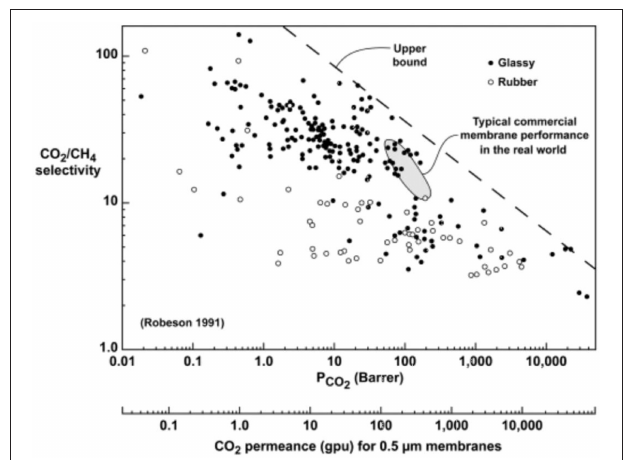
FIGURE 1 | Robeson trade-off toward CO 2 /CH 4 gas pair separation. Reproduced from Favvas et al. (2017). Copyright obtained from Elsevier (license number